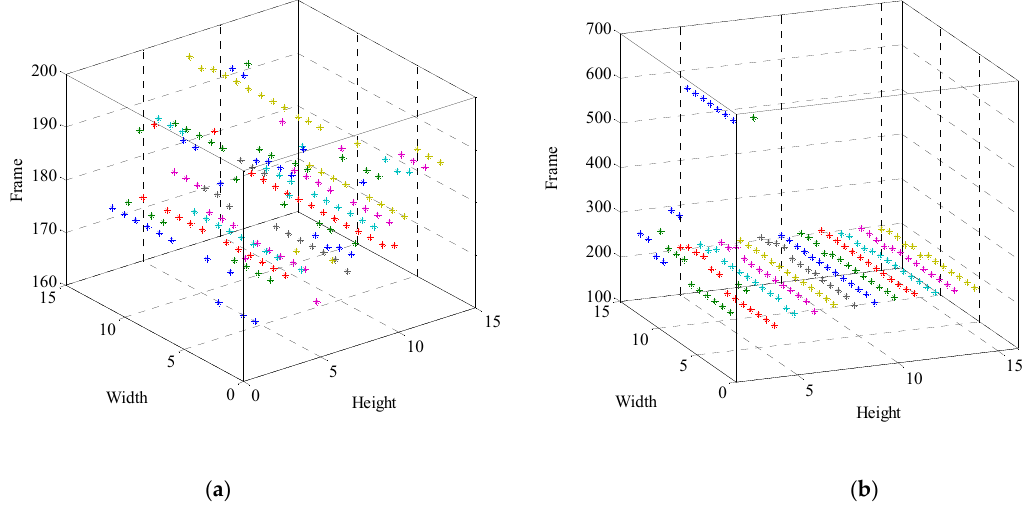
Figure 23. The 3D scatter diagram of selection frames with the sensitive region size variation: ( a ) The 3D scatter diagram of selection frames for #1; ( b ) The 3D scatter diagram of selection frames for #2.